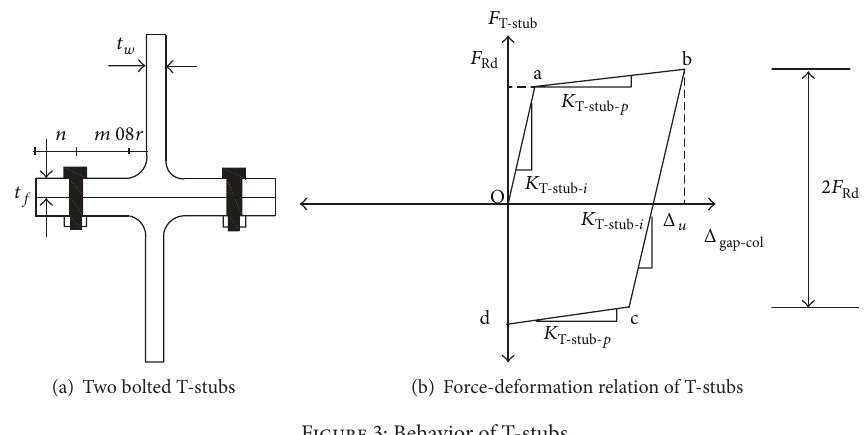
Figure 3: Behavior of